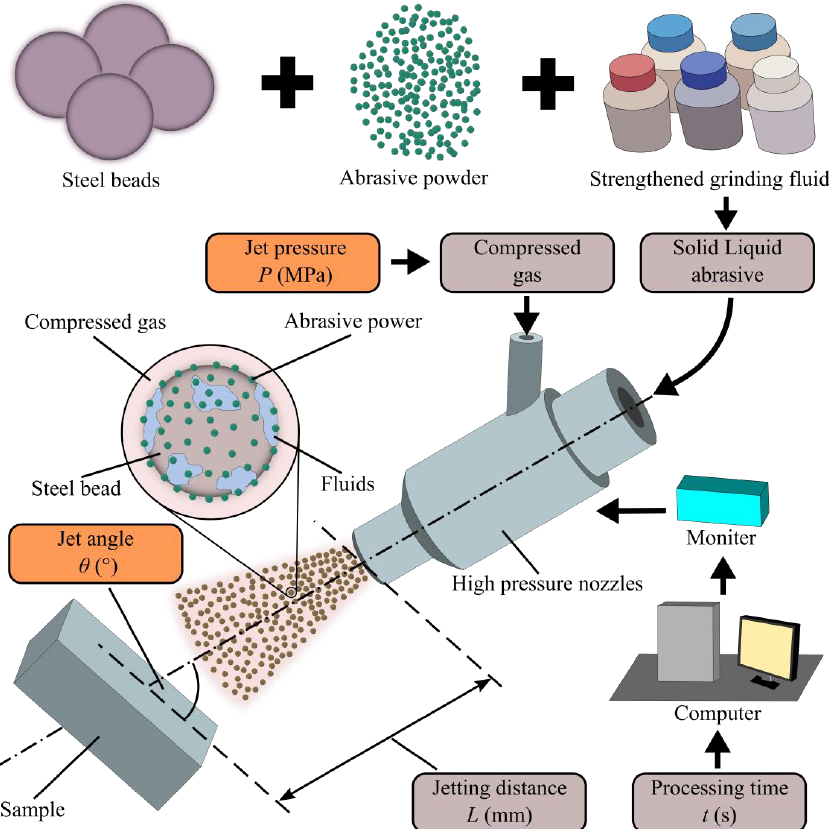
Figure 1. Parameter setting and schematic illustration of the treatment process in SMGT. The concentrated modified solution is prepared with borax, triethanolamine,